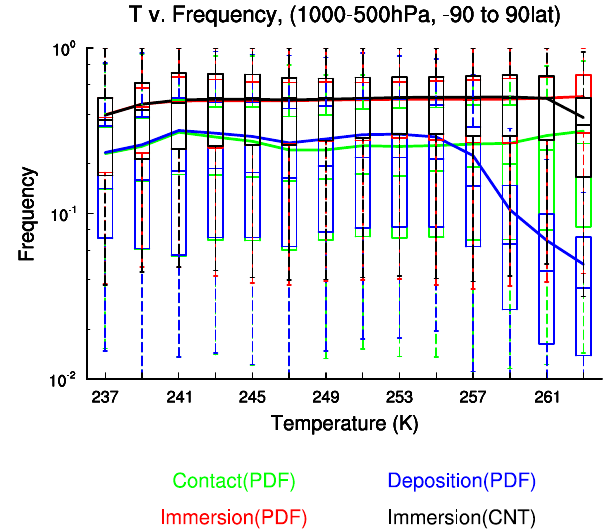
Figure 8. Simulated frequency of immersion freezing (red), depo- sition nucleation (blue) and contact nucleation (green) in the PDF simulation and immersion freezing (black) in the CNT simulation as a function of temperature sampled every 3h. The whiskers rep- resent the 5th and 95th percentiles, and the boxes represent the 25th and 75th percentiles and the